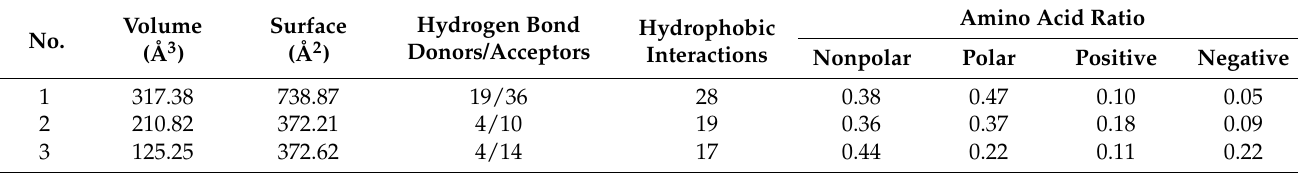
Figure 3. Potential ligand-binding pockets of CpAcp SH3b6. ( A – C ) Three pockets identified using online software DoGSiteScorer are shown with mesh and arranged according to their size in green, magenta, and orange color, respectively. The residues with side chains involved in forming the respective pockets are shown as sticks in the images at bottom. The residues labeled with red font are those with conserved score over 7 identified in ConSurf analysis. Table 2. Parameters of ligand-binding pockets of CpAcp